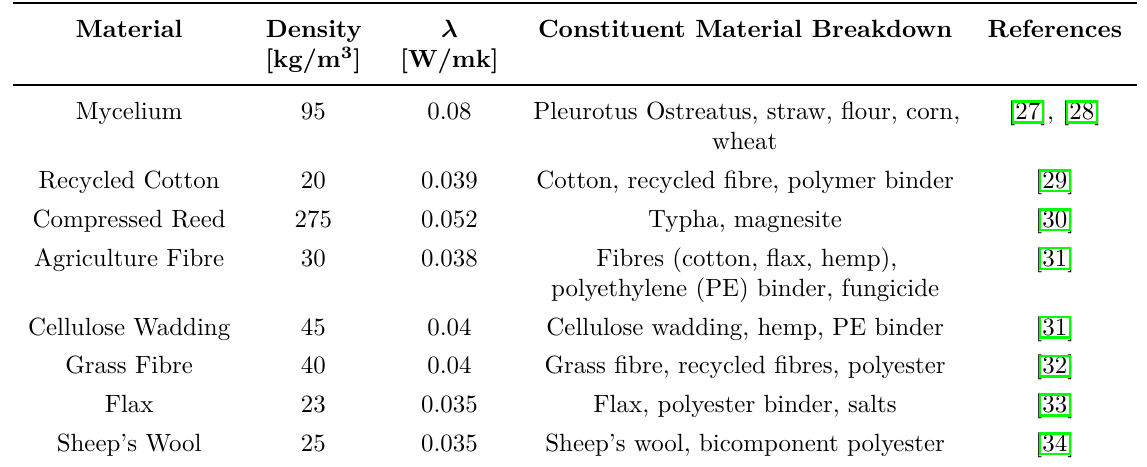
Table 1. Key characteristics for the assessed bio-based insulation materials.